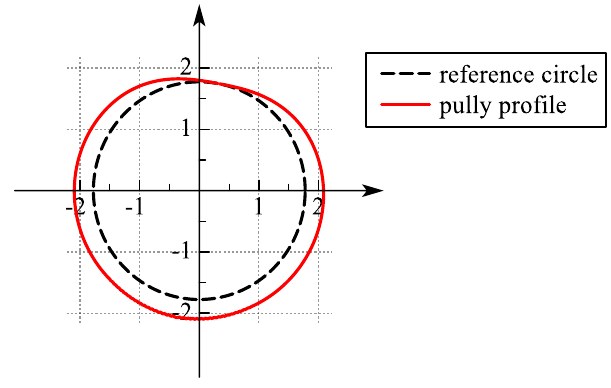
Figure 4. The optimized pully profile.